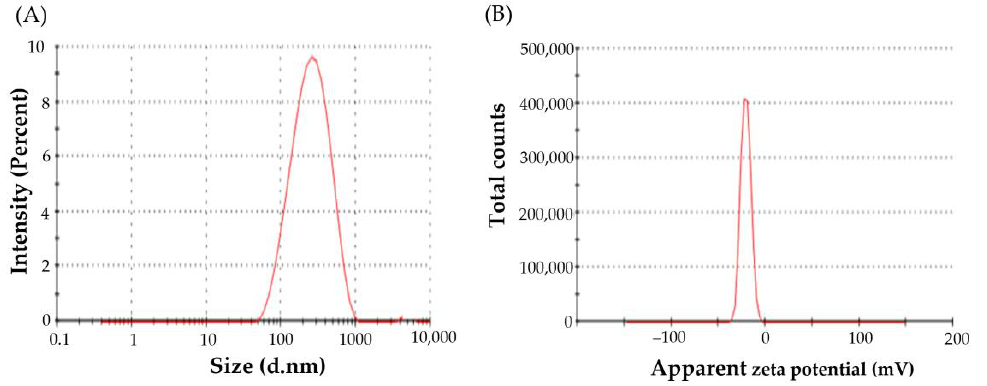
Figure 3. ( A ) DLS size distribution plot; ( B ) zeta potential.